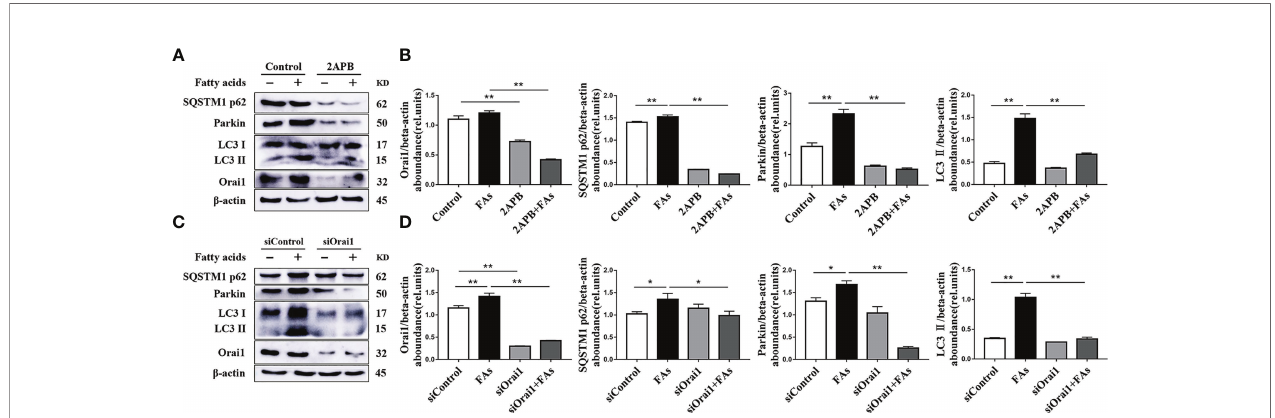
FIGURE 9 | ORAI1 levels affect the expression of autophagy-related protein. CD4 + T cells were sorted from spleens from 1-d old calves and stimulated with 2APB or siORAI1 before FAs treatment with 12 h (A) Western blot analysis of autophagy-related protein in treatment with 2APB (n = 4 per group). (B) Relative abundance of autophagy-related protein in treatment with 2APB (n = 4 per group). (C) Western blot analysis of autophagy-related protein in treatment with siORAI1 (n = 4 per group). (D) Relative abundance of autophagy-related protein in treatment with siORAI1 (n = 4 per group). The data of the control were used to normalize other treatments. Comparisons among groups were calculated using a one-way ANOVA with a Duncan correction. The data presented are the mean ± SEM, *P ≤ 0.05, **P ≤ 0.01 indicate differences from control or FAs